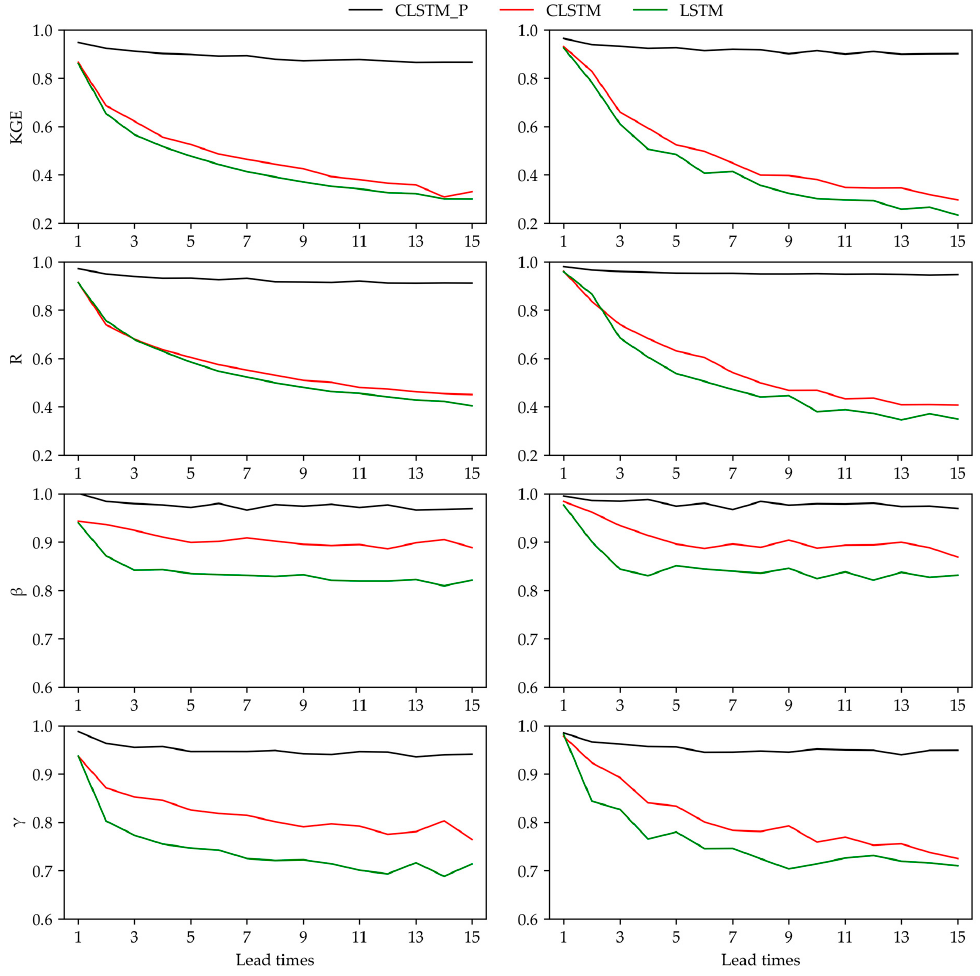
Figure 8. Performance of streamflow forecasts at different lead times. The left column shows the mean values of KGE, R, β , and γ for 49 stations, and the right column shows their median values. Table 2. Percentage (%) of stations that improved compared to the default LSTM model, the cas- caded LSTM model (CLSTM), and the cascaded LSTM with the perfect precipitation (CLSTM_P) model KGE and its three components (R, β and γ ).